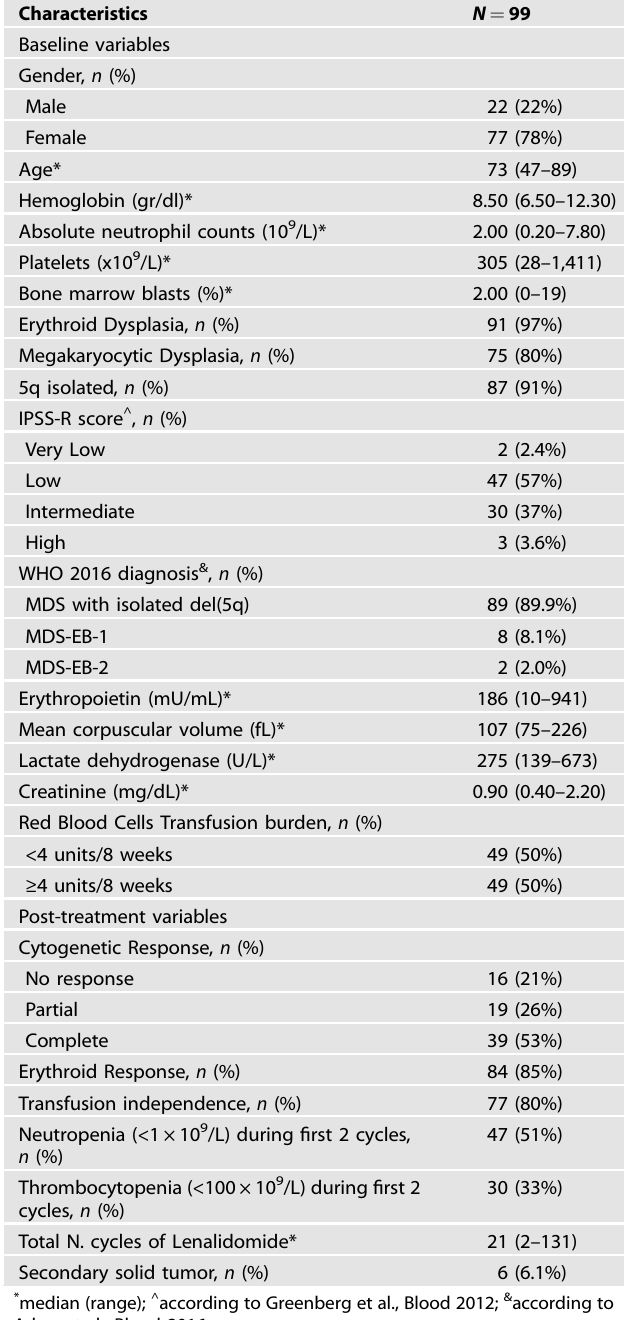
Table 1. Patients ’ characteristics at baseline and after lenalidomide